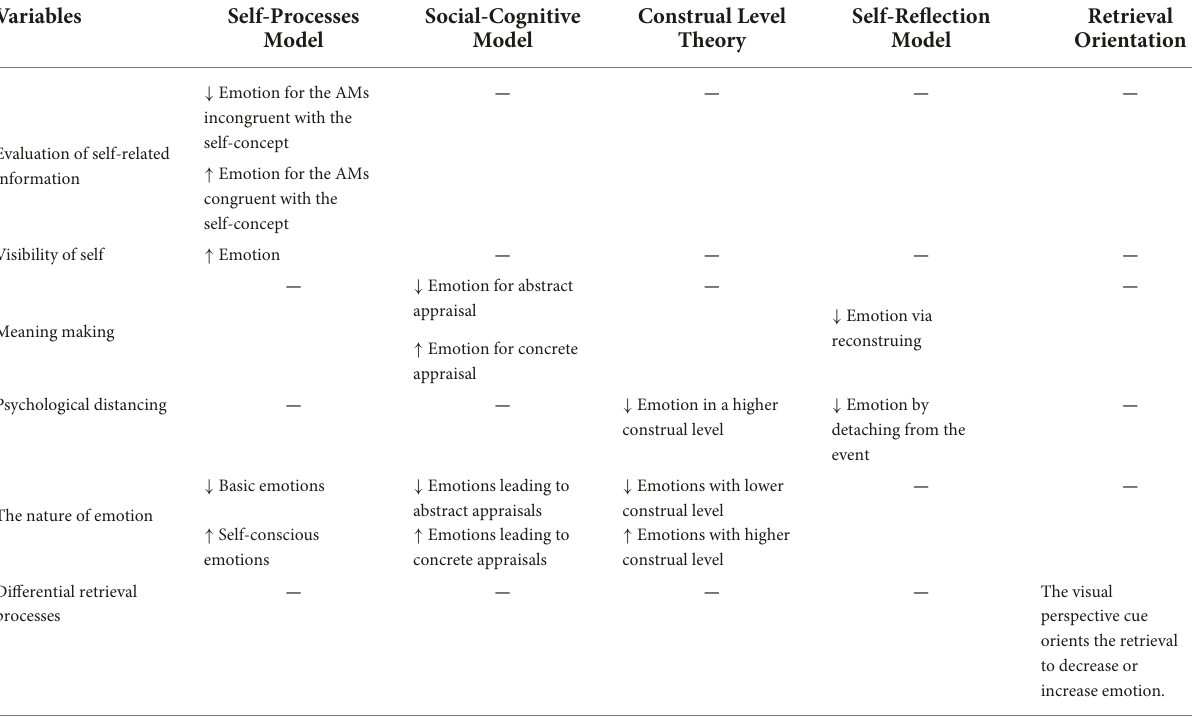
TABLE 1 Variables proposed to explain the impact of an observer-like perspective on